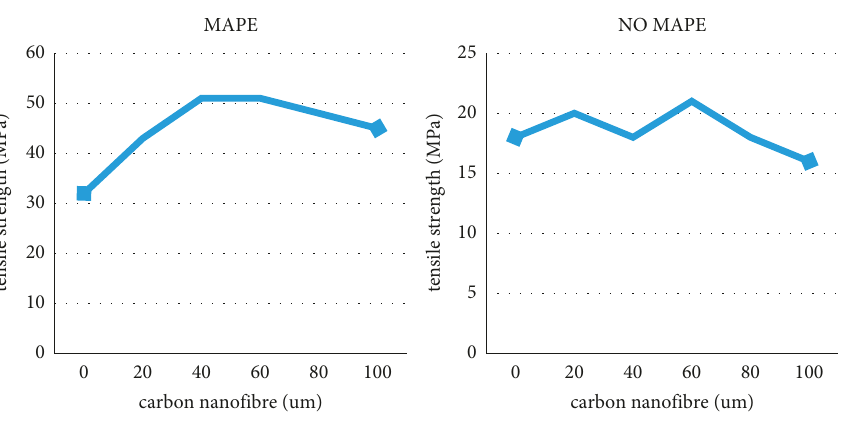
Figure 8: Comparison of tensile properties of composites.